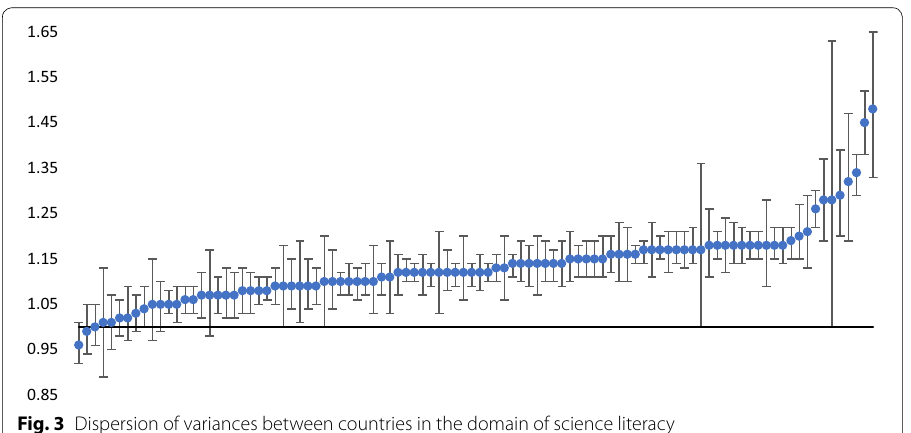
Fig. 3 Dispersion of variances between countries in the domain of science literacy